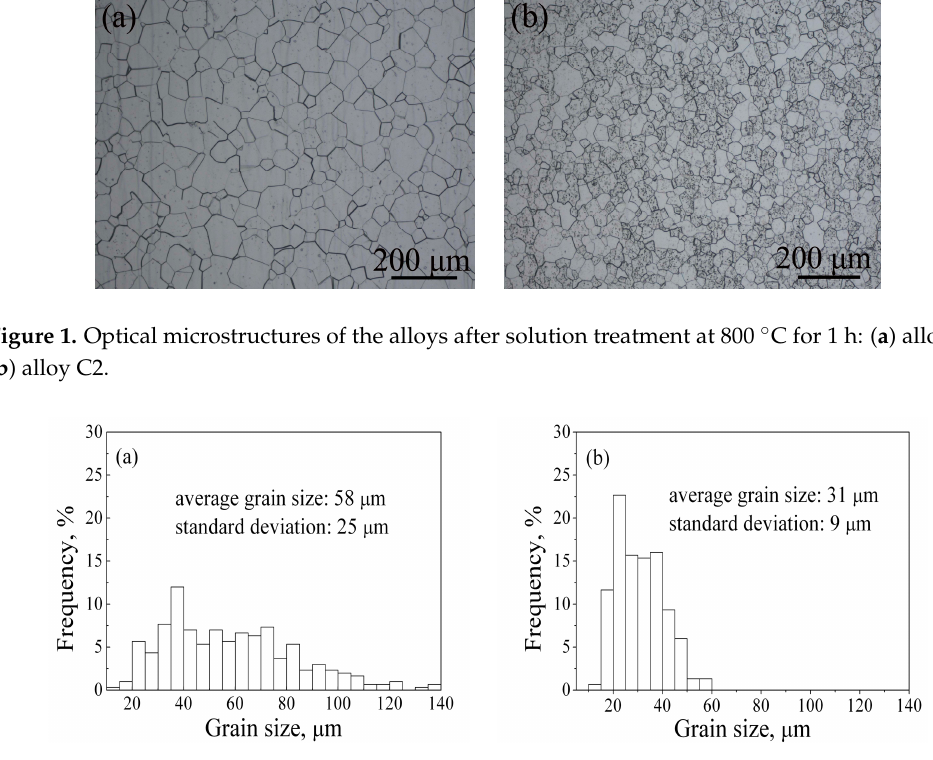
Figure 2. Grain size distributions of alloys: ( a ) alloy C1; ( b ) alloy C2.